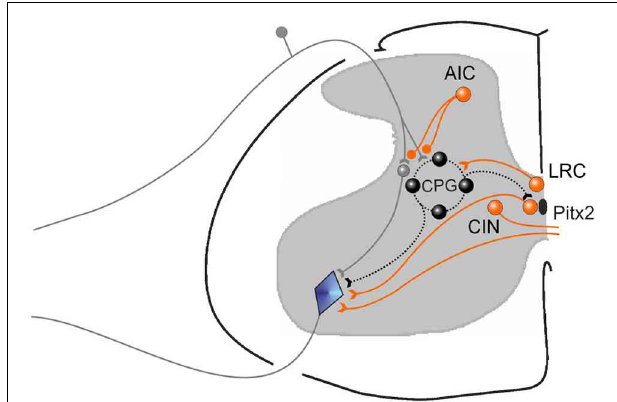
FIGURE 14 | Cartoon showing different functional groups of cholinergic neurons that are suggested by our results. A population for afferent input control (AIC) is illustrated, some of which are known to have direct presynaptic terminals on cutaneous afferents, as well as terminals on GABAergic interneruons (not shown) that may also be responsible for suppressing afferent input. AIC neurons act on their targets through both muscarinic and nicotinic receptors. A population of cholinergic neurons (LRC) that can control the locomotor rhythm by activating the central pattern generator for locomotion (CPG) are also shown. Their precise positions are unknown. They act on their target neurons via M3 receptors. Pitx2 neurons give rise to C terminals on motoneurons and increase motoneruron excitability by reducing the AHP amplitude via M2 receptors. They are also known as V0c neurons. Commissural cholinergic interneurons (CIN) are illustrated, many of which terminate on contralateral motoneurons and produce EPSPs in motoneurons via M-currents blocked by atropine. Other partition or central canal cluster cells with unknown function are likely also present in the spinal